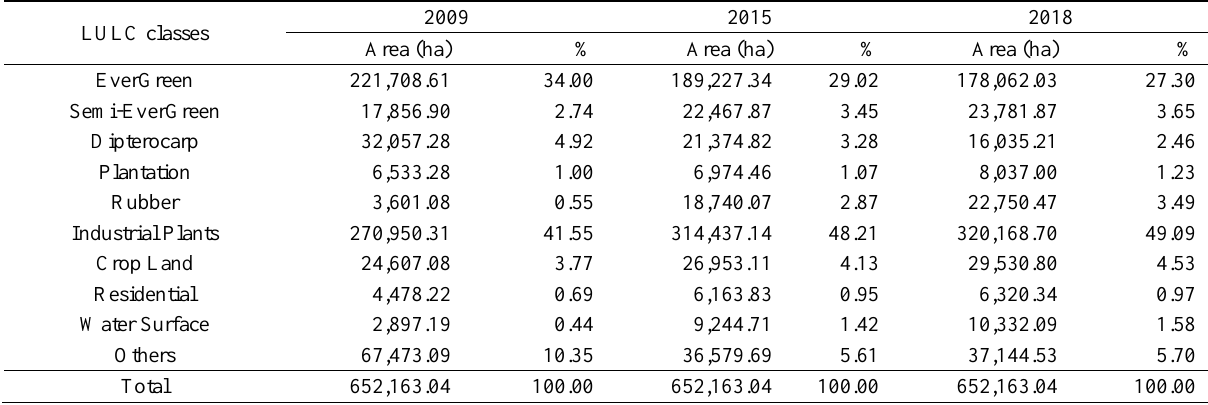
Table 2. Area of LULC categories over years (ha)